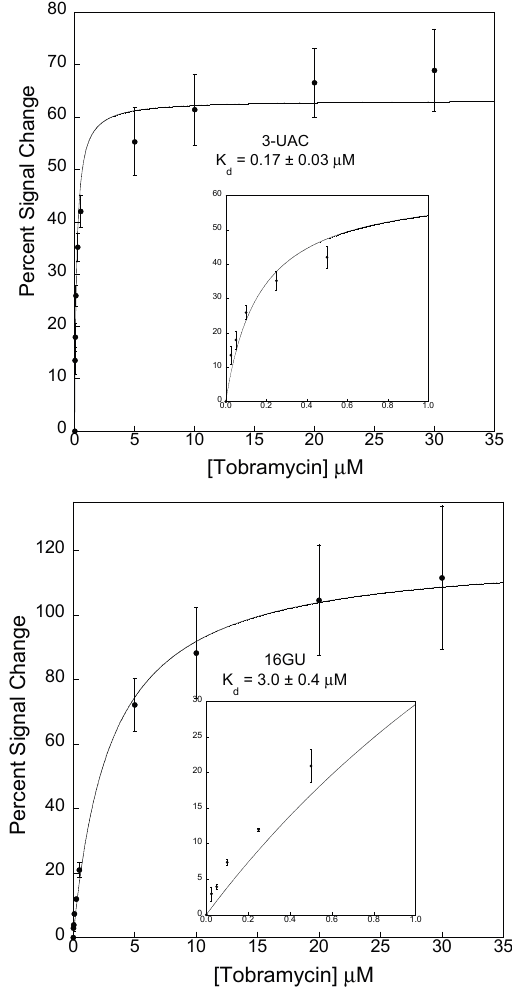
Figure 6. Sensors fabricated with mutated sequences stabilizing the target-free state exhibit reduced affinity (as indicated by the increase in dissociation constants—K d ). ( Top ) For example, the sensors fabricated with the 16GU sequence exhibit a dissociation constant of 3.0 ± 0.4 µM and a 112% ± 22% signal change at 30 µM tobramycin; ( Bottom ) Similarly, the sensors fabricated with the 3-UAC sequence exhibit a K d of 0.17 ± 0.03 µM, but with a lower overall signal change of 69% ± 8% at saturating conditions. In agreement with the predicted stabilities of the target-free structure, the more stable 16GU ( − 2.13 kcal/mol) exhibits the highest K d , followed by 3-UAC ( − 1.6 kcal/mol), both of which are higher than the high-gain parent sequence ( − 0.66 kcal/mol) with a dissociation constant of 0.08 μ M. These data represent titration curves calculated as percentage signal change using voltammetric peak currents as described in the experimental section. Each data point represents the average and standard deviation of at least three independently fabricated